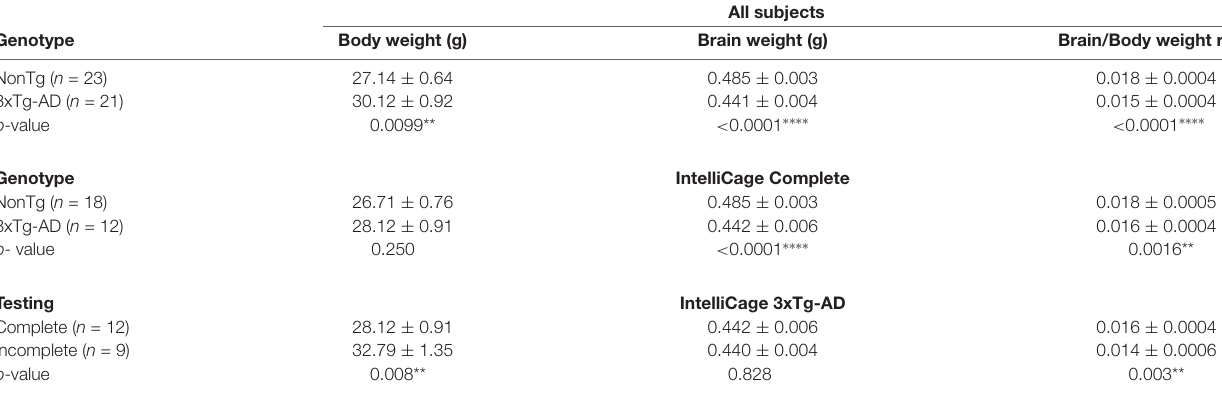
TABLE 2 | Body and brain weight differences between 3xTg-AD and NonTg